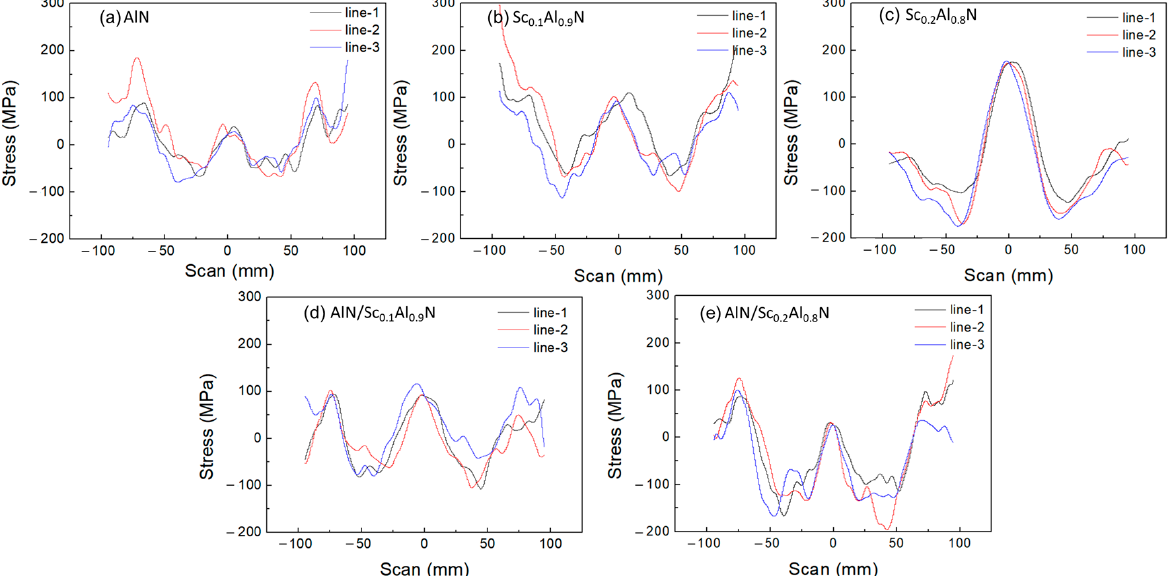
Figure 5. The stress distribution of ( a ) AlN, ( b ) Sc 0.1 Al 0.9 N, ( c ) Sc 0.2 Al 0.8 N, ( d ) AlN/Sc 0.1 Al 0.9 N, and ( e ) AlN/ Sc 0.2 Al 0.8 N